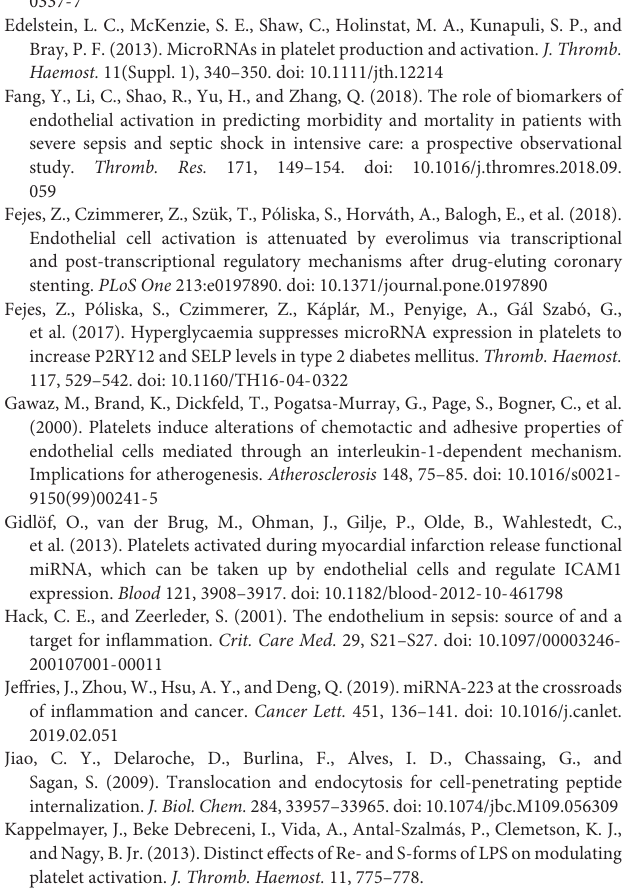
Supplementary Table 1 | The main demographical and laboratory parameters of both study groups. Septic patients ( n = 13) were enrolled after admission to the intensive care unit (ICU) of the Department of Internal Medicine and sample collection was conducted prior to any sepsis-specific treatment. WBC count raised, while platelet count reduced in sepsis subjects vs. controls ( P < 0.01). In addition, serum C-reactive protein (CRP) and procalcitonin (PCT) levels were highly elevated in septic individuals based on their cut-off values ( < 4.6 mg/L and < 0.5 µ g/L, respectively) indicating the development of severe inflammation. Sepsis was diagnosed based on the criteria of the American College of Chest Physicians/Society of Critical Care Medicine Consensus. Sequential Organ Failure Assessment (SOFA) score was determined by the clinicians. Age- and sex-matched control individuals ( n = 13) were enrolled among volunteers or staff members from the Department of Laboratory Medicine. Results are expressed as mean ± SEM or median with interquartile range (IQR), as appropriate. Unpaired